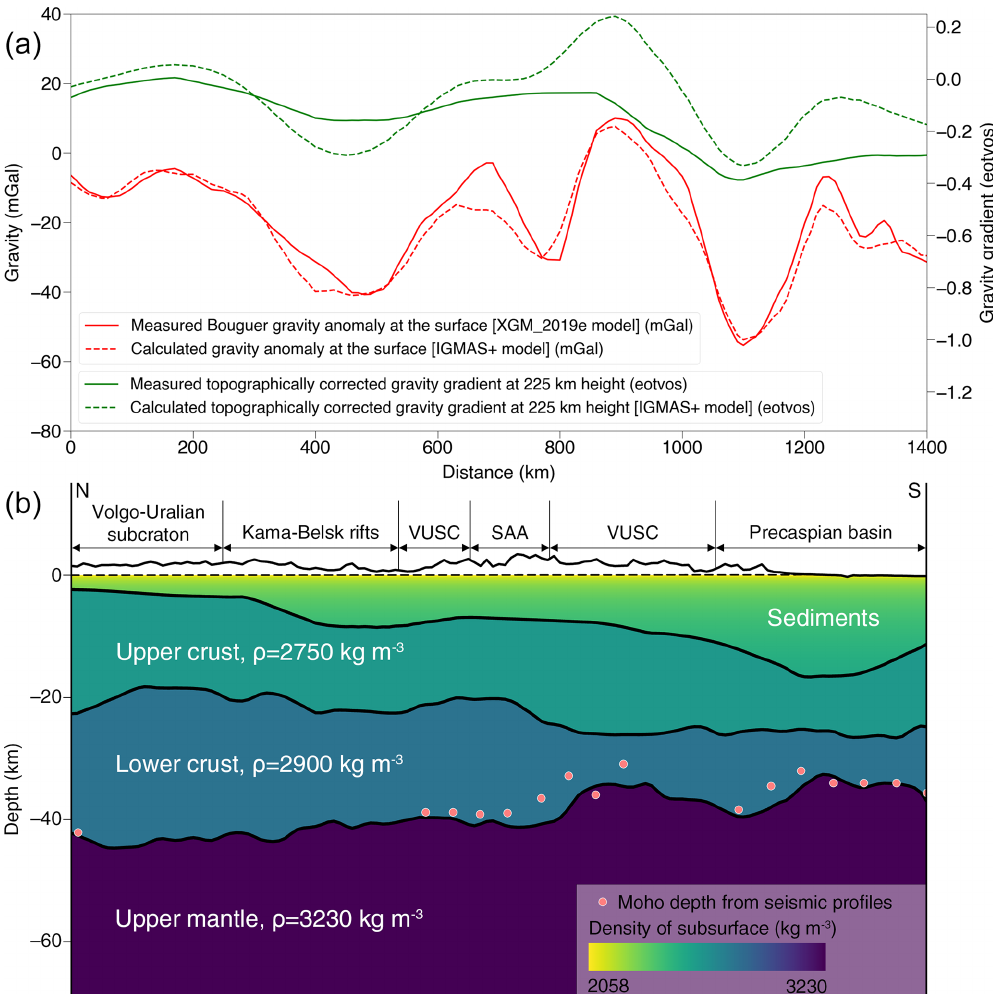
Figure 13. Measured and calculated Bouguer gravity anomalies and the topographically corrected vertical gravity gradient anomalies from the crustal model (a) and IGMAS + model north–south cross-section in the eastern part of Volgo–Uralia (b) – see Fig. 3 for the reference on the map. Subsurface is vertically exaggerated by the factor of 10 and topography is by the factor of 100. VUSC stands for Volgo–Uralian subcraton and SAA for Sernovodsk–Abdulinsk